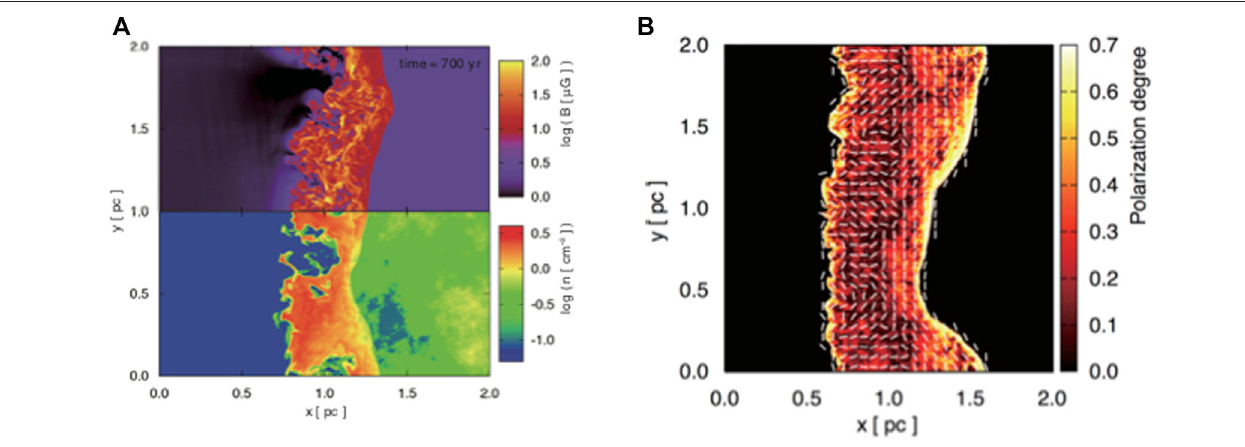
FIGURE 4 | The simulation results of Inoue et al. (2013). The left panel (A) shows the two-dimensional slice of the magnetic- fi eld strength (upper half) and the number density (lower half). The right panel (B) shows the results of synthetic observations of the synchrotron polarimetry. The white bars indicate the magnetic- fi eld orientation and the color indicates the fractional polarization. Reproduced from Inoue et al. (2013, The Astrophysical Journal